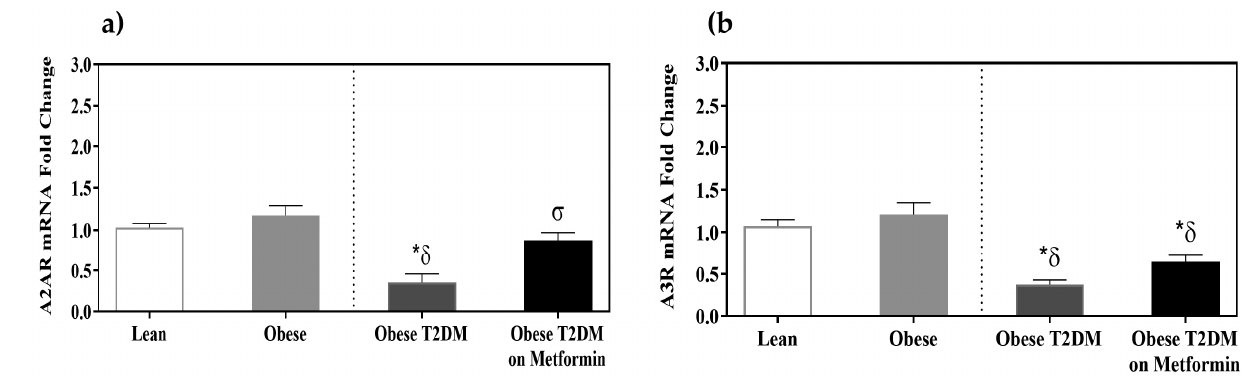
Figure 5. mRNA expression of adenosine receptors in the PBMCs of lean, obese, T2DM and T2DM on Metformin groups: ( a ) A2AR; and ( b ) A3R. Results are presented as Mean ± SEM. One-way ANOVA on ranks, p < 0.001 for A2AR, and A3R, followed by Dunn’s test for pairwise comparisons and comparisons against normal-weight group, * p < 0.05 vs. normal-weight subjects; δ p < 0.05 vs. obese; σ p < 0.05 vs. T2DM subjects.